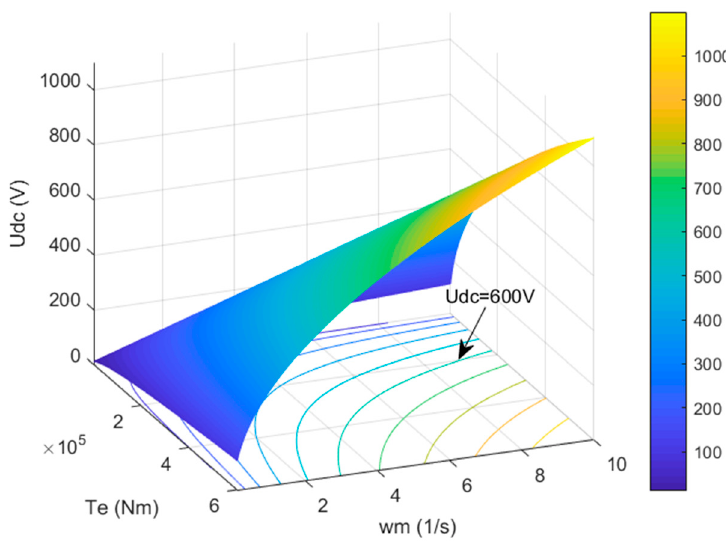
Figure 5. External characteristics of the PMSG–AR system.